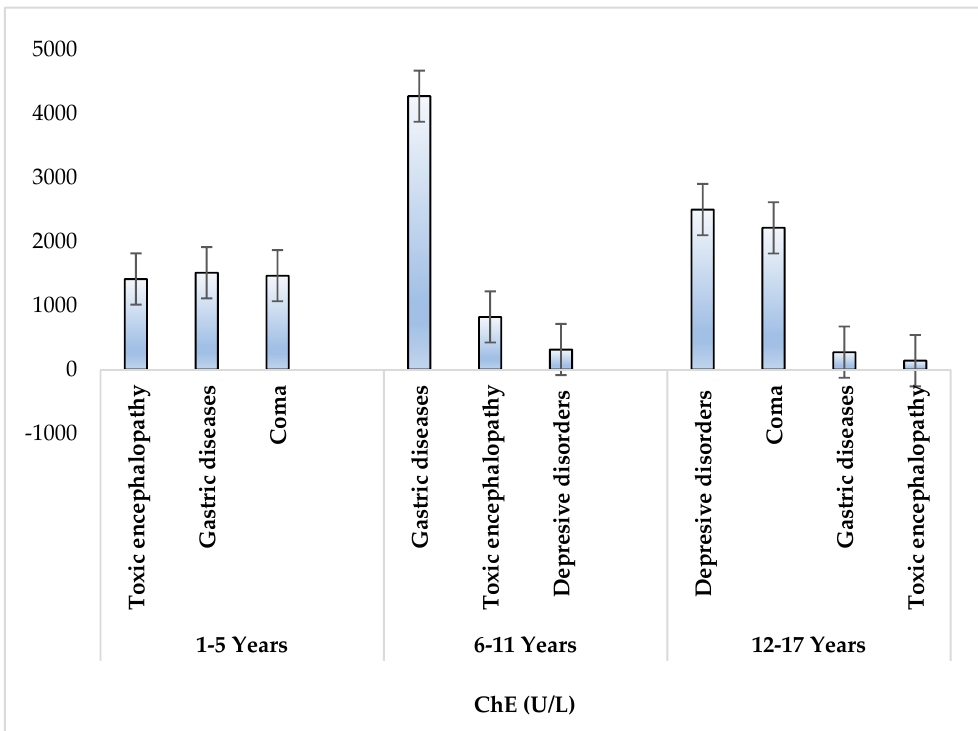
Figure 3. Mean serum ChE concentration (IU/L) levels in pediatric patients by age and diagnosis.